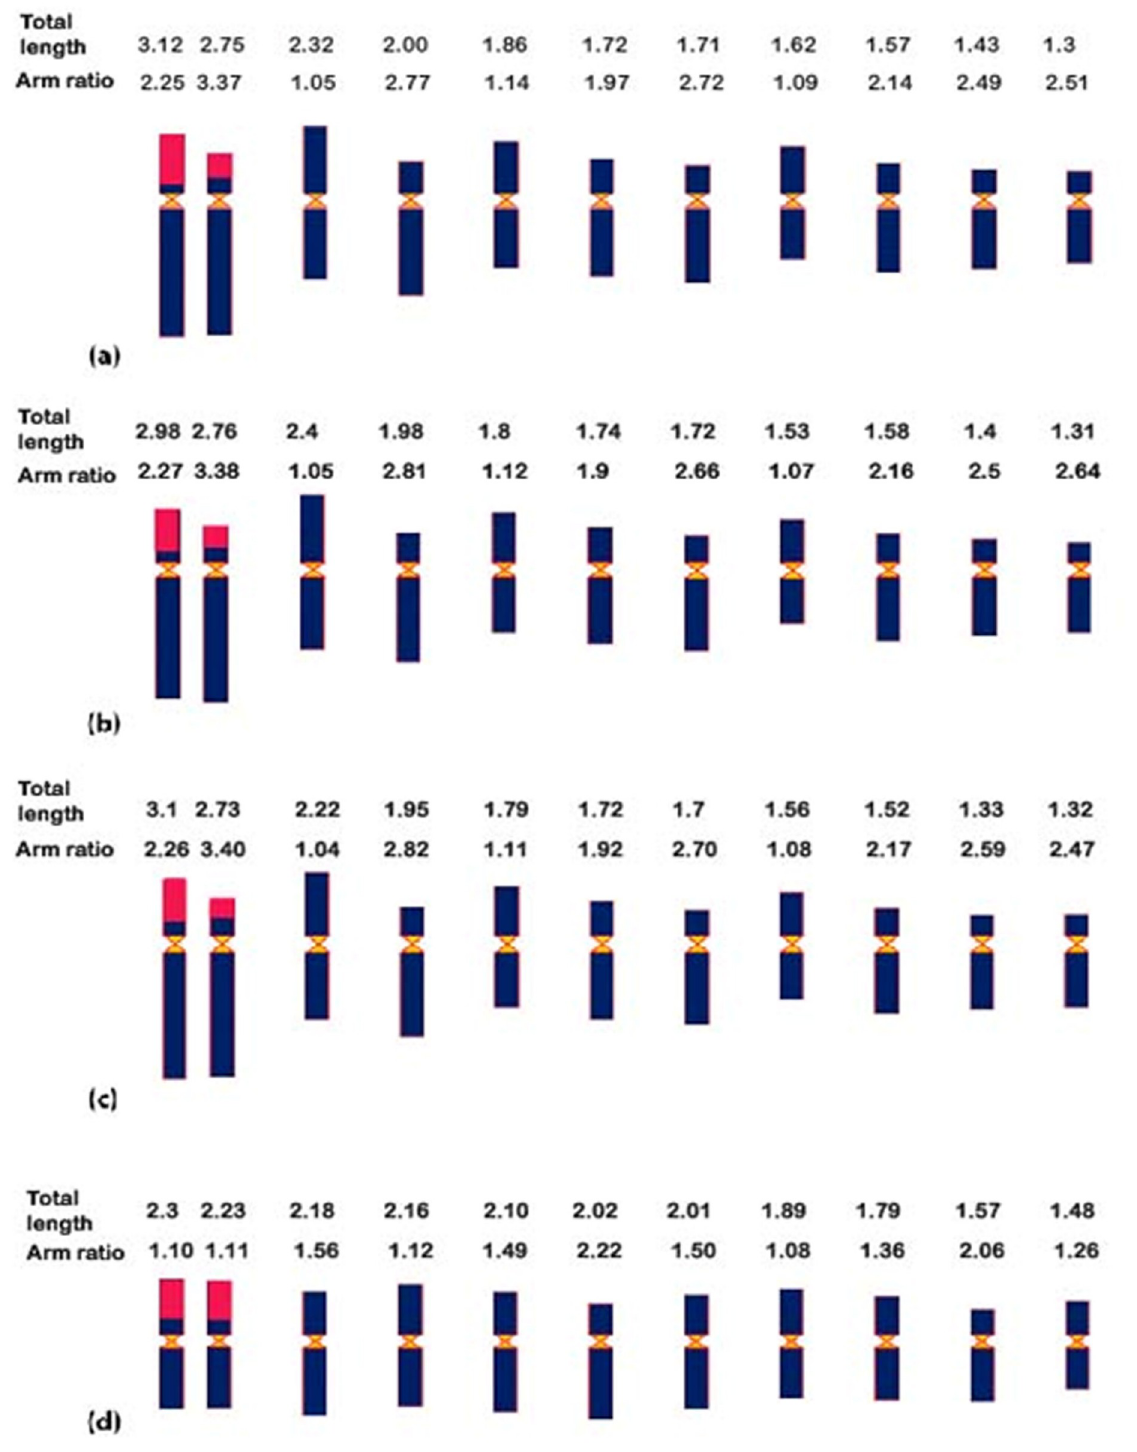
Fig 2. Total length and arm ratio of chromosome. Schematic representation of chromosome arranged in descending order of their length: a . Karyogram of Bio-13 ( C . winterianus ), b . Karyogram of Manjari ( C . winterianus ), c . Karyogram of Medini ( C . winterianus ), d . Karyogram of Krishna ( C . flexuosus